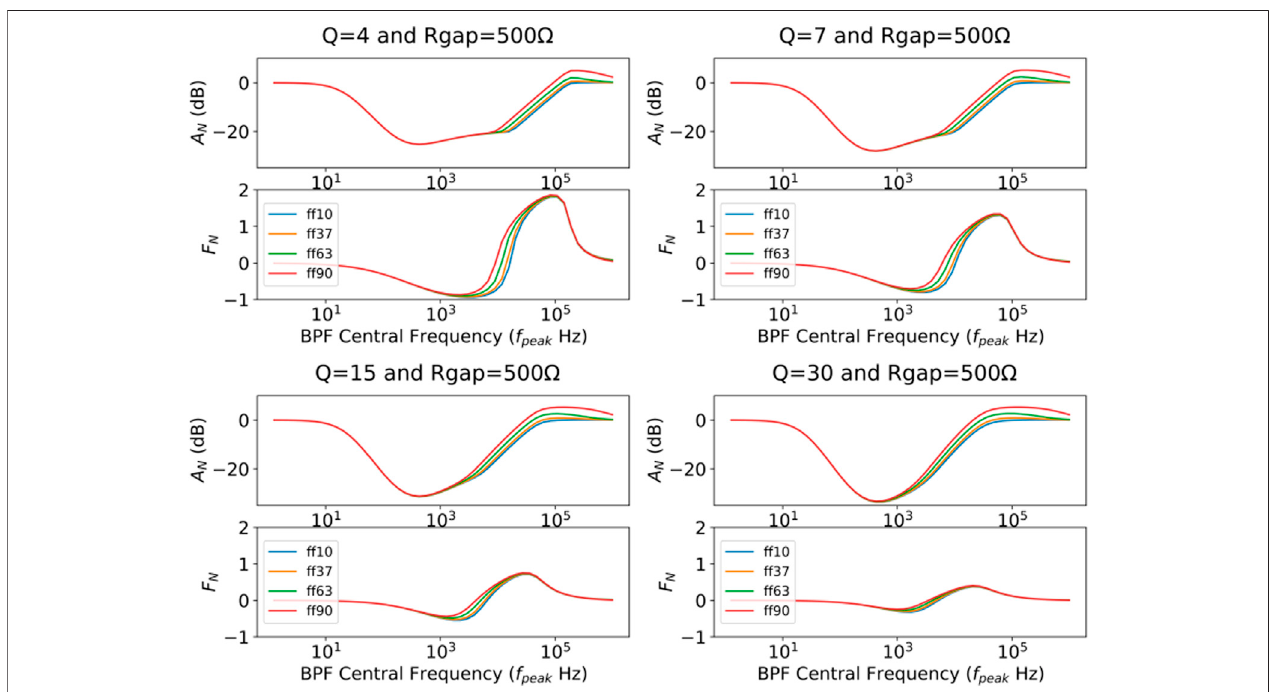
FIGURE8| Oscillation-Based(OB)Spectroscopynormalizedresponsefordifferentvaluesof Q f parameter,witha fi xedR gap (cid:2) 500.Thesimulationsareperformed over different fi ll factor levels (10%, 37%, 63%, and 90%).